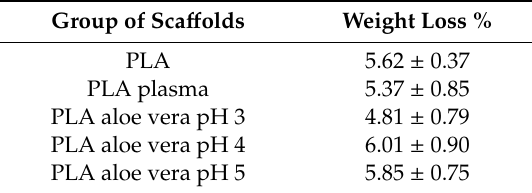
Table 2. Average weight loss (%) of the scaffolds after five-day enzymatic degradation.